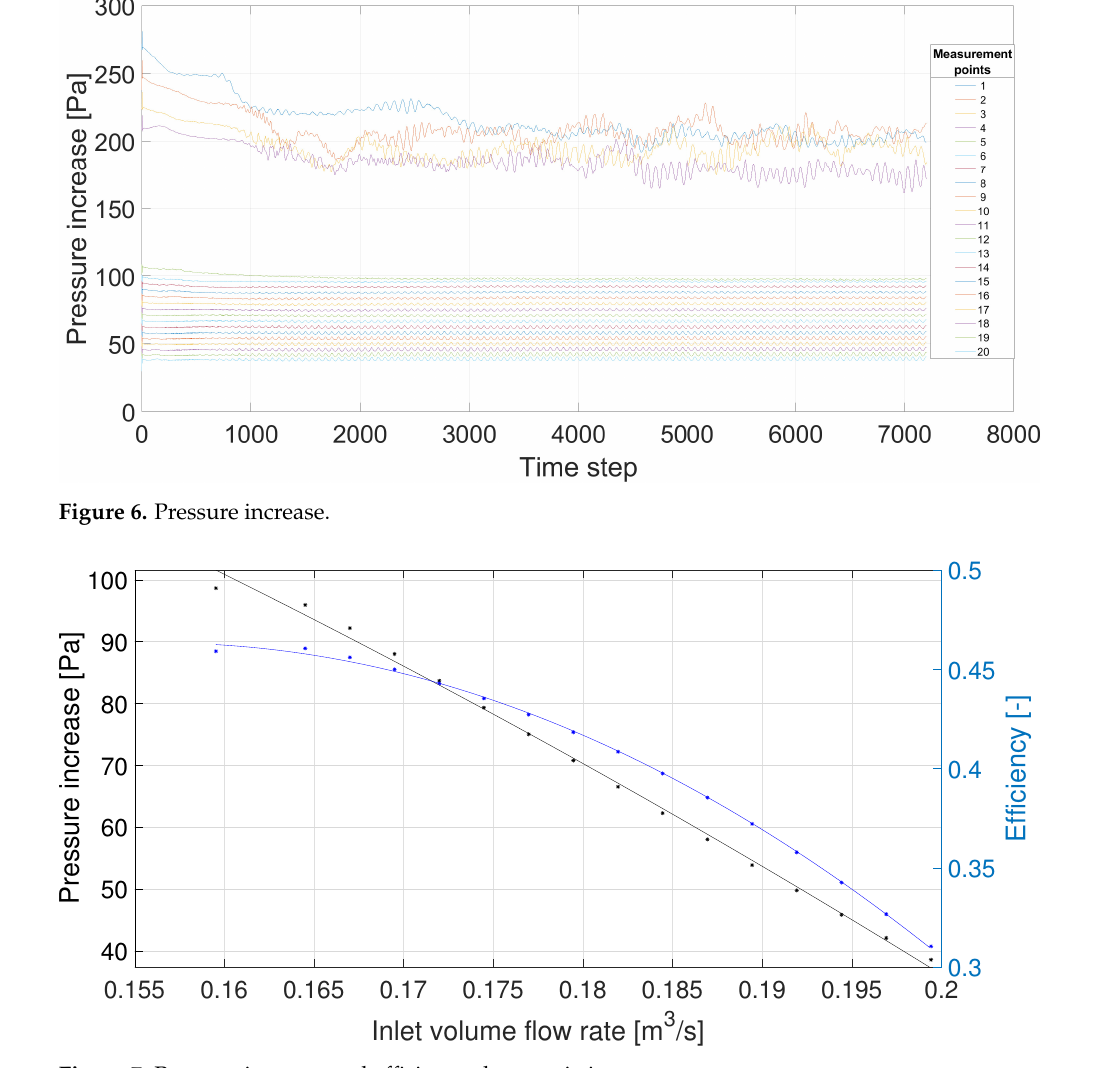
Figure 7. Pressure increase and efficiency